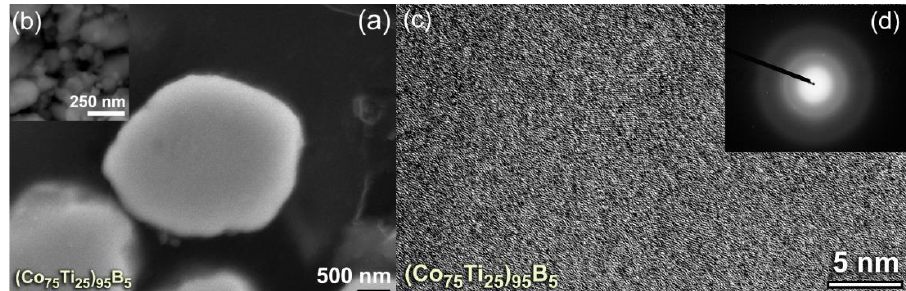
Figure 3. ( a ) High-magnification FE-SEM micrographs of ( b ) the cross-sectional view and ( b ) morphology for (Co 75 Ti 25 ) 75 B 25 powders obtained after 50 h of MA time. The FE-HRTEM and nanobeam diffraction pattern (NBDP) of the powders after this stage of MA are displayed in ( c ) and ( d ), respectively. The X-ray di ff raction (XRD) patterns of MA-(Co 75 Ti 25 ) 100 − x B x (x: 2, 10, and 15 at%) obtained